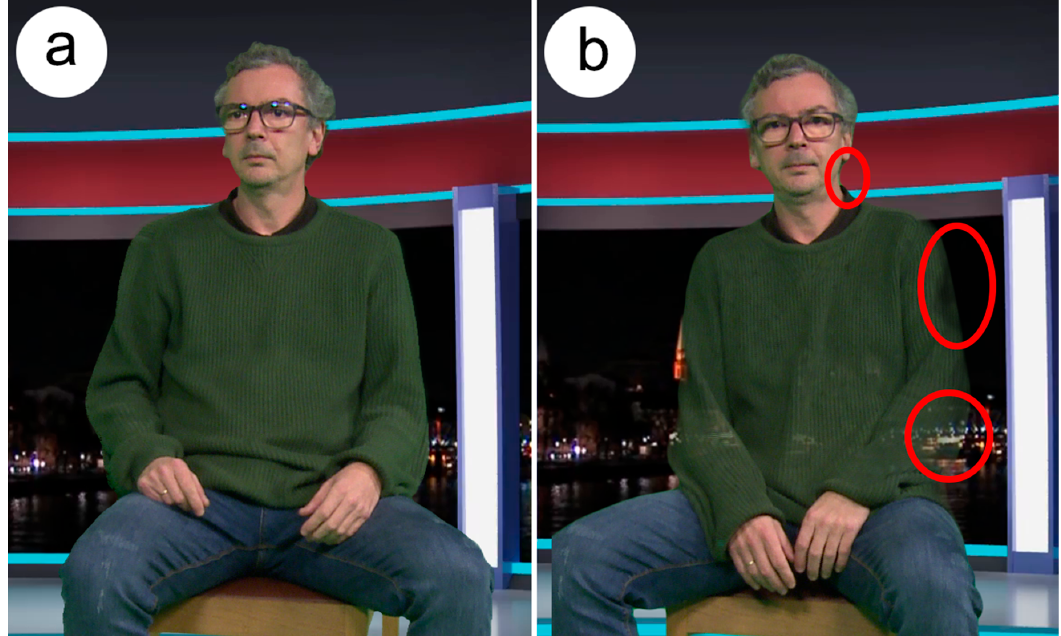
Figure 14. Composite image using a proper cyclorama calibration. Note the defined edges of the actor’s green jersey and the absence of artifacts on the composition ( a ). Composite image with a non-homogeneous background lighting ( b ). Note the transparencies in the green jersey, the blurred edges and the halos appearing in the neck of the actor. Modifying the chroma-keying threshold in order to reduce the undesired transparencies increases the halos and makes different artifacts appear in the background due to the illumination differences in the cyclorama.